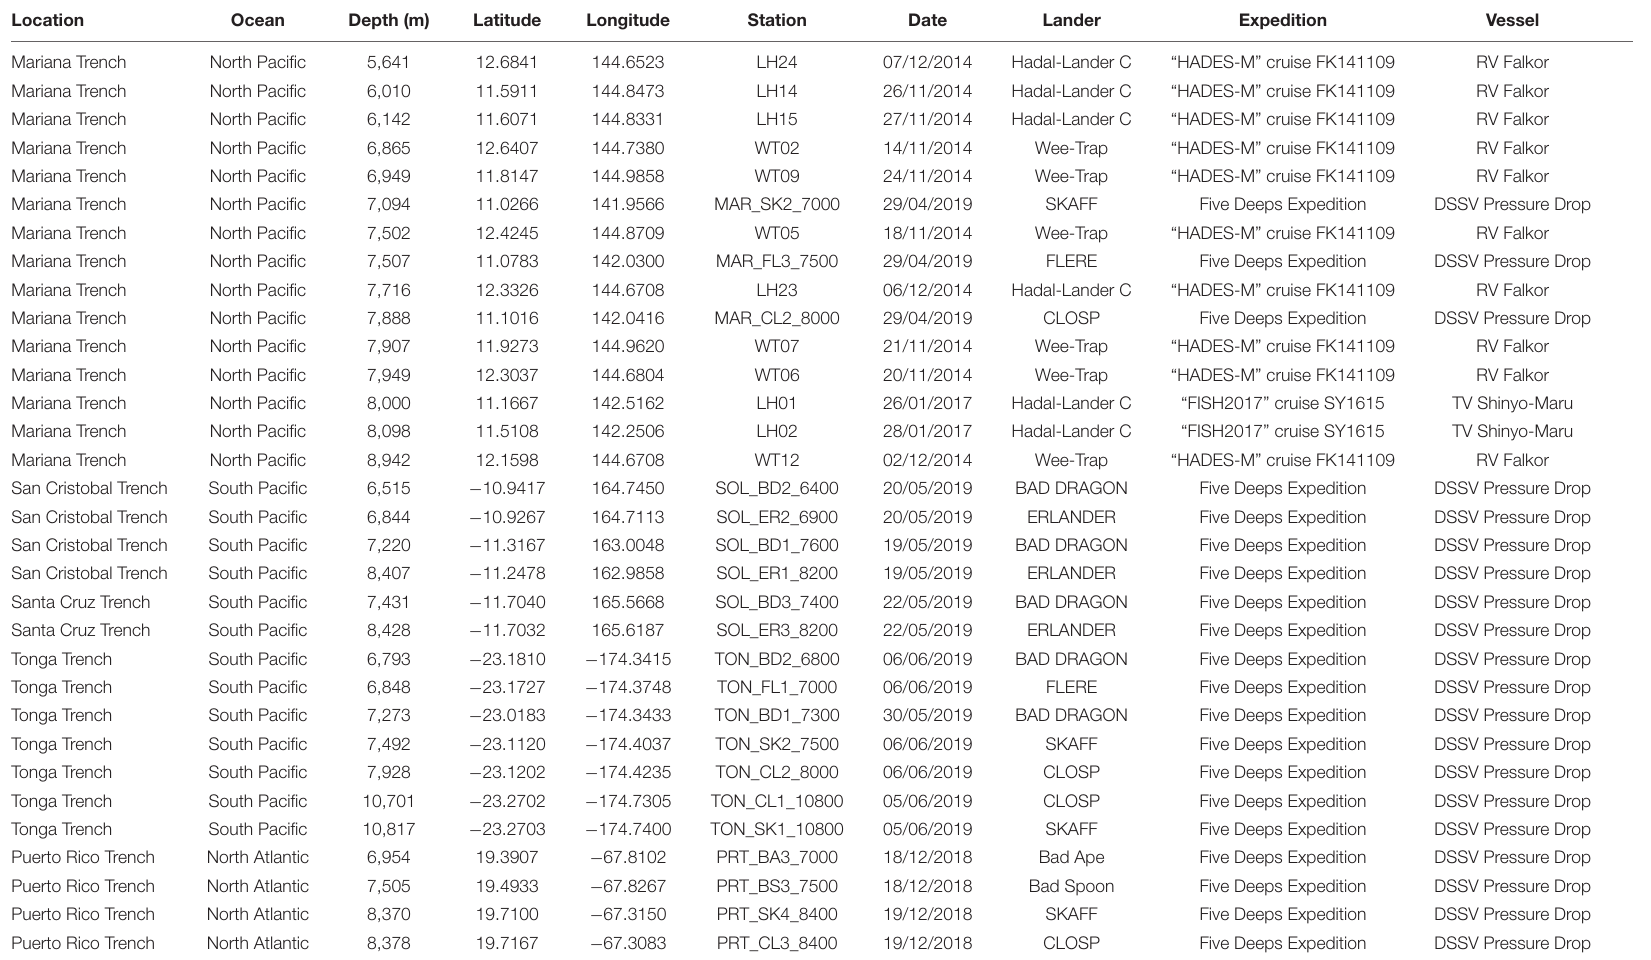
TABLE 1 | Locations and baited lander deployments where the amphipod Hirondellea dubia was recovered during this study.